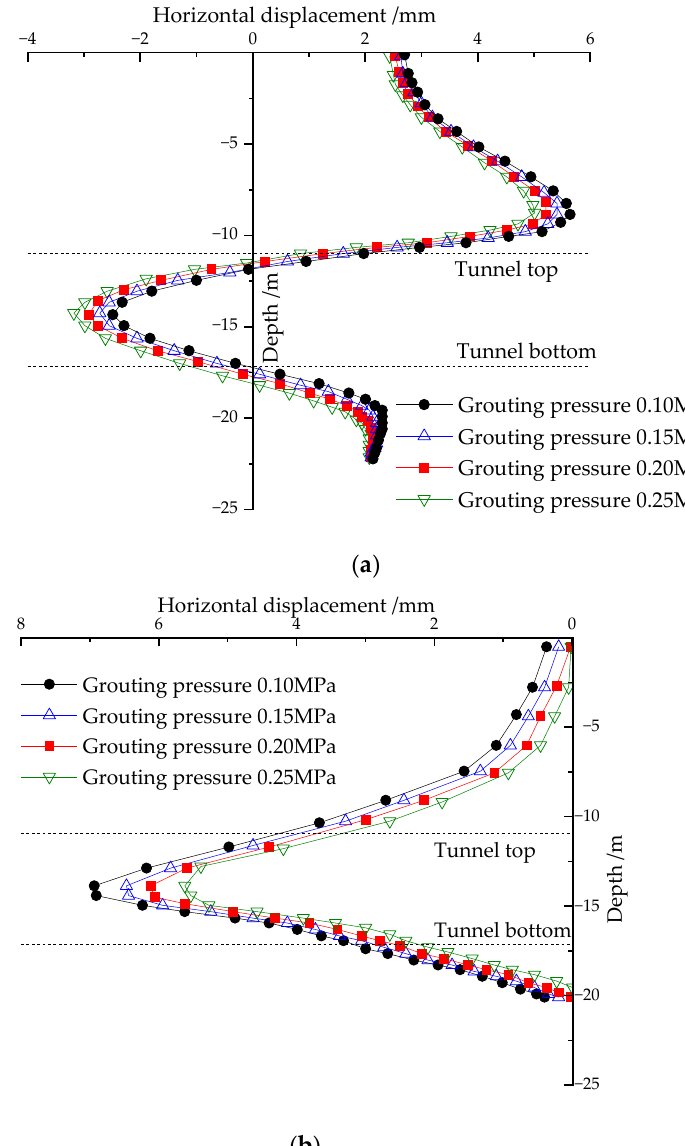
Figure 13. Curves of horizontal displacement of surrounding soil with various grouting pressures: ( a ) outer side of curved tunnel axis; ( b ) inner side of tunnel.